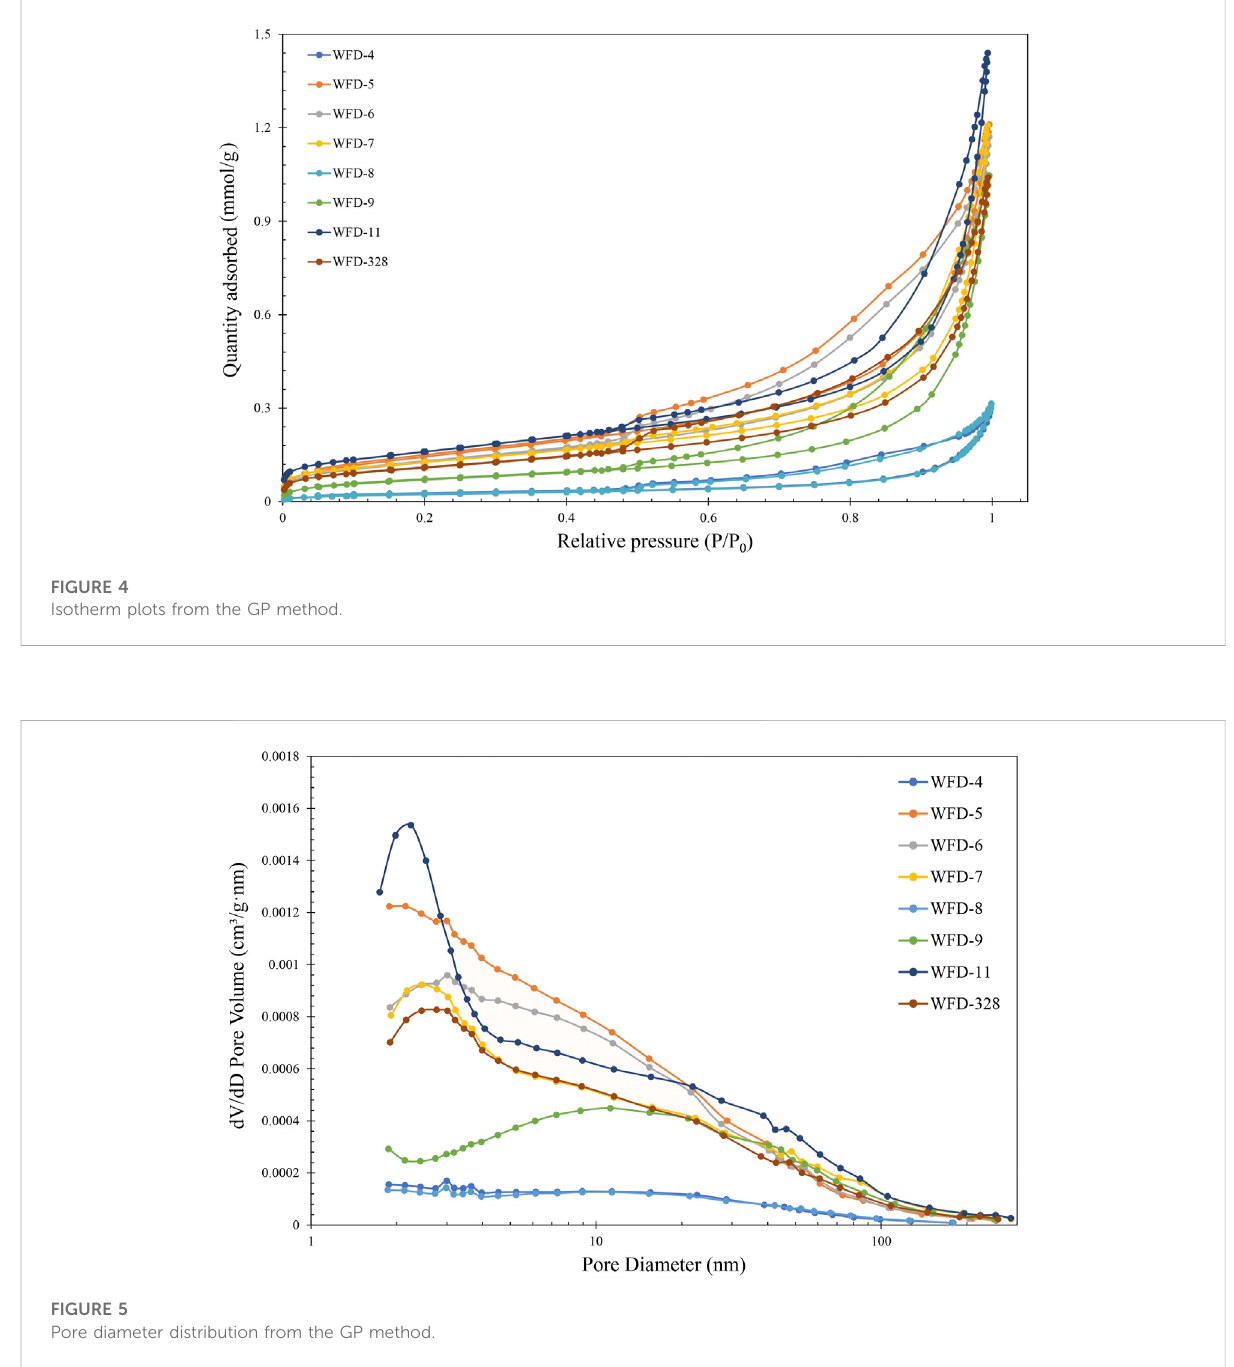
(Table 4). In addition, samples WFD-5 and WFD-6 show an